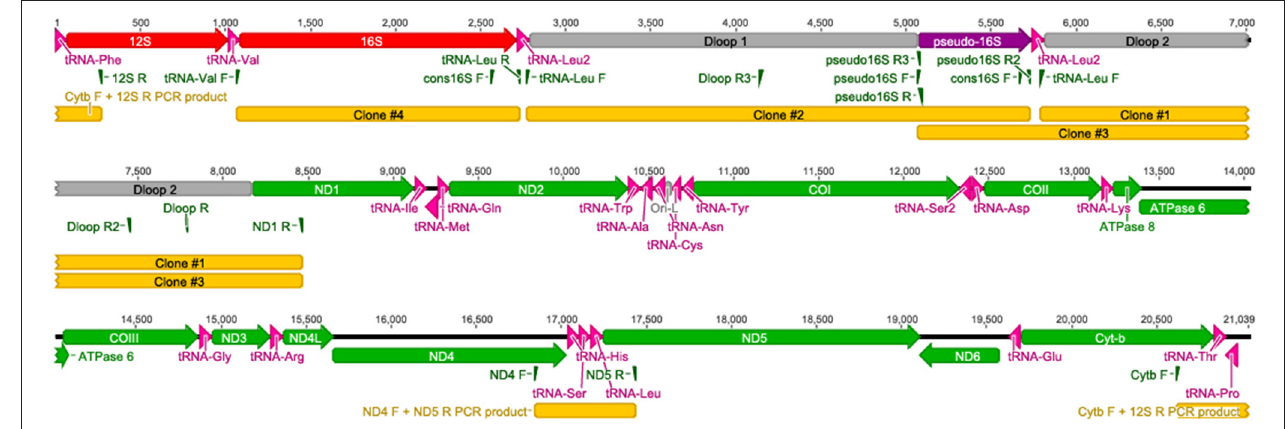
FIGURE 2 | Primer binding sites for targeted resequencing of the A. limnaeus mtgenome. Specific primers were used to resequence parts of the A. limnaeus mtgenome. Longer fragments were cloned into vectors for sequencing.